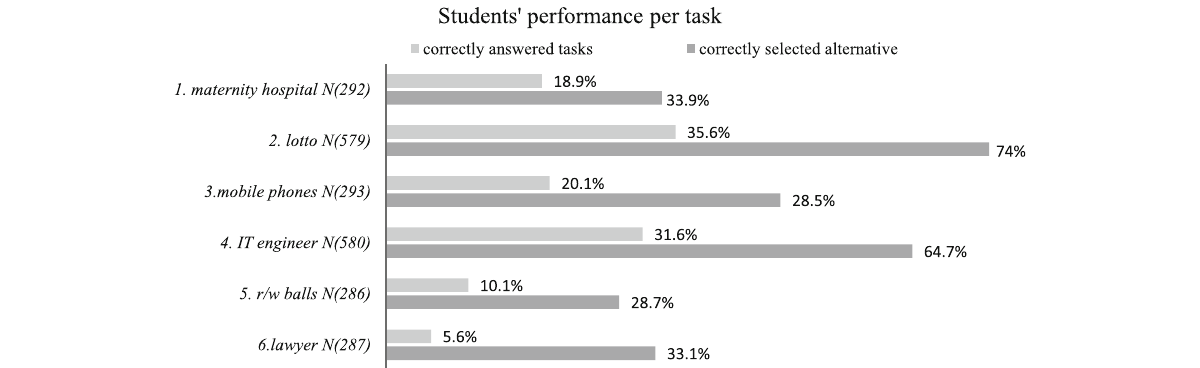
Fig. 1 Percentage of students who successfully answered each task. N , number of examinees who selected some answer regardless on existence of explanation